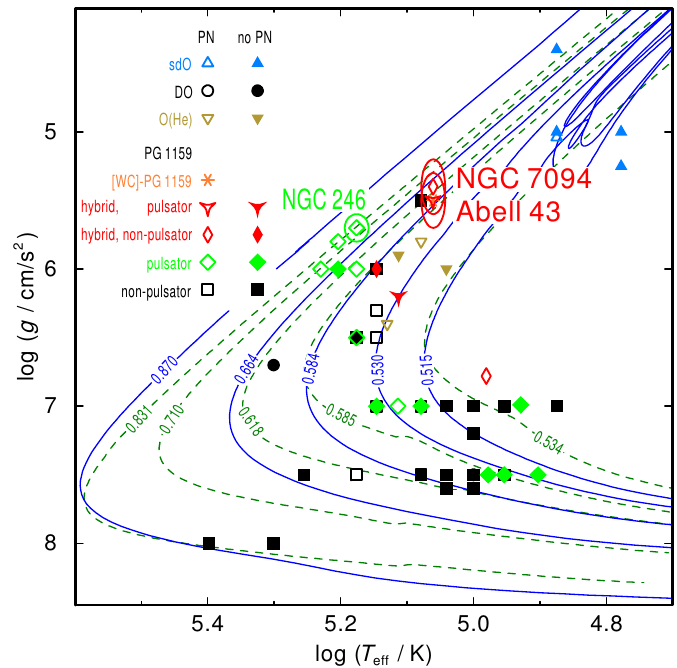
Figure 3. Positions of the CSPNe of NGC7094, A6643, and NGC246 (within their error ellipses) and related objects in the log T eff − log g plane compared with evolutionary tracks (labeled with the respective masses in M (cid:12) ) of VLTP stars ([15], full lines) and of hydrogen-burning post-AGB stars ([19], calculated with initial solar metalicity; dashed